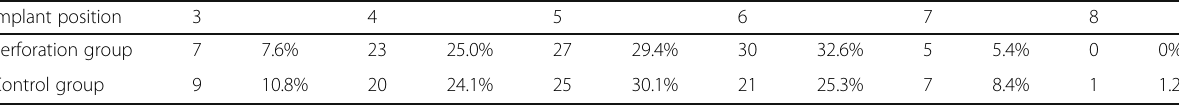
Table 1 Distribution of implant positions